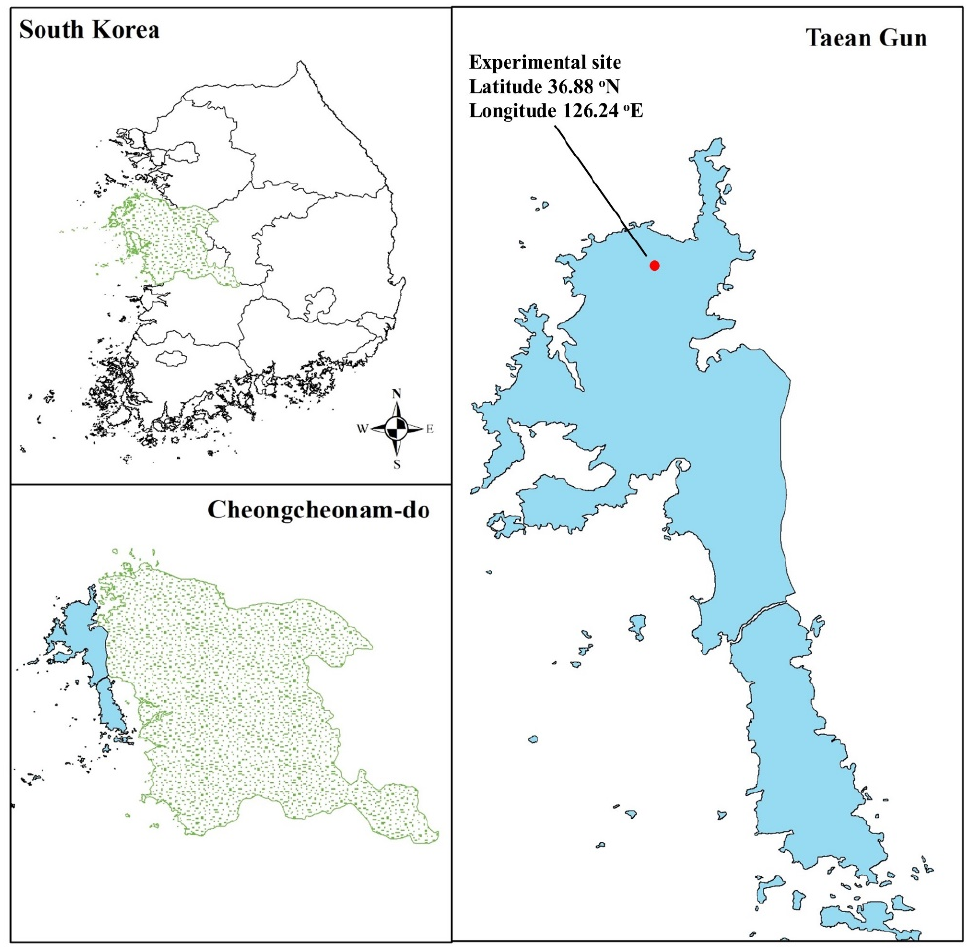
Figure 1. Geographic location of experimental greenhouse site.